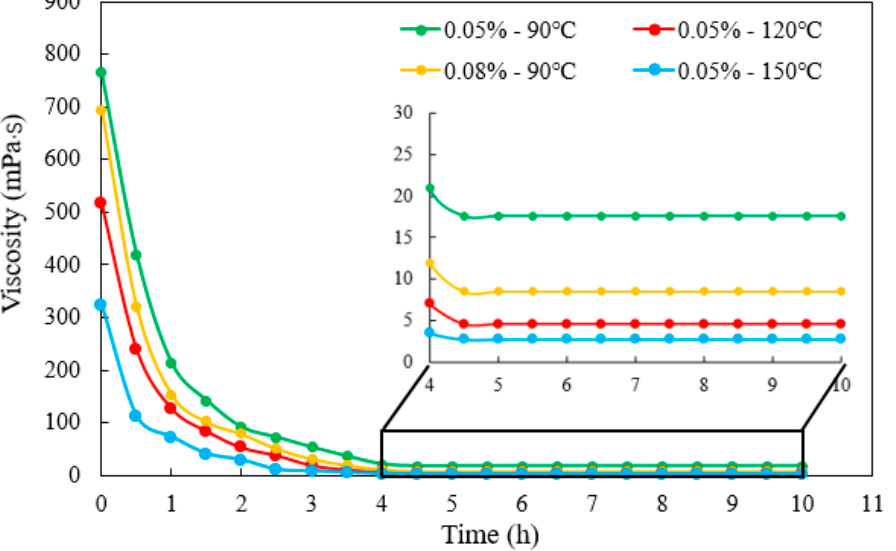
Figure 11. Gel-breaking performances at different temperatures.